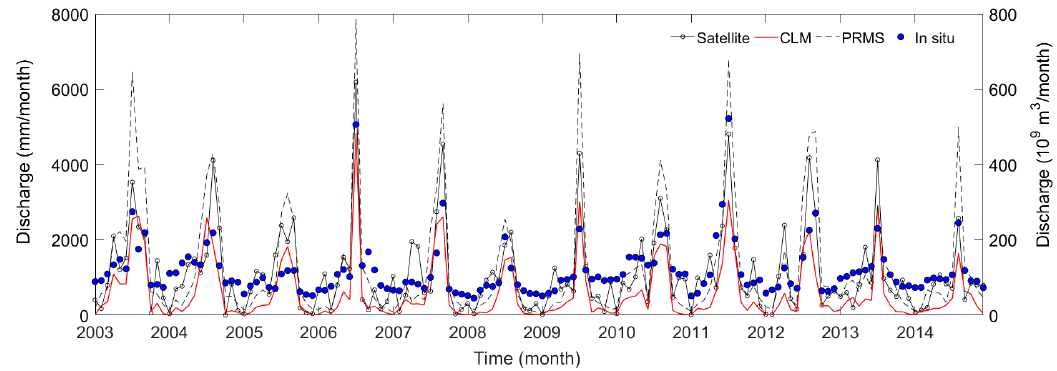
Figure 11. Comparison of the satellite-based discharge, model-based discharge (CLM and PRMS), and in situ discharge sum of the five major river basins in South Korea.